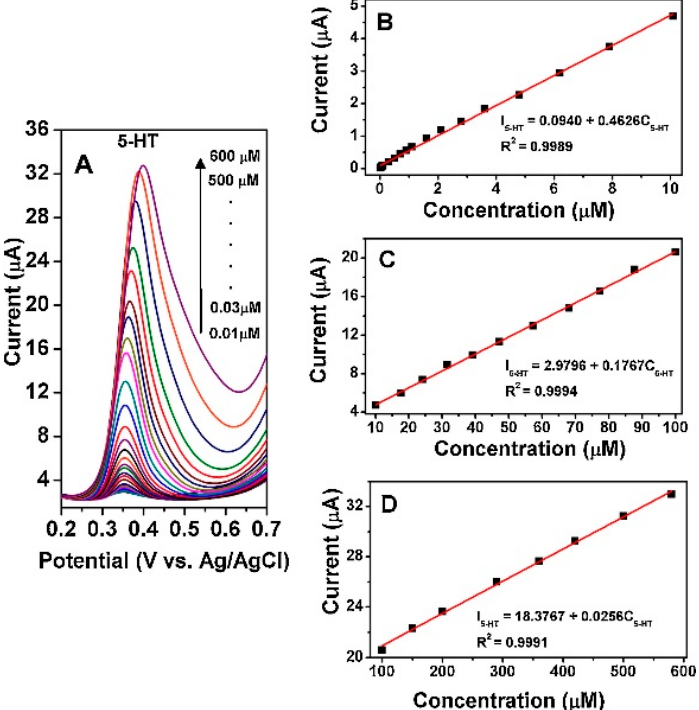
Figure 16. ( A ) differential pulse voltammetry (DPV) of 100 kGy WO 3 /GCE in 0.1 M phosphate buffer saline (PBS) (pH 7.0) containing different concentrations of serotonin (5-HT) (0.01–600 μ M). ( B – D ) show the plots of the electrocatalytic oxidation peak current as a function of 5-HT concentration within the range of 0.01–10 μ M, 10–100 μ M and 100–600 μ M, respectively. Reprinted from Sensors and Actuators B: Chemical, Vol 238 Anithaa A.C. et al., Highly sensitive and selective serotonin sensor based on gamma ray irradiated tungsten trioxide nanoparticles, Pages No. 667–675, Copyright (2017), with permission from Elsevier [158].